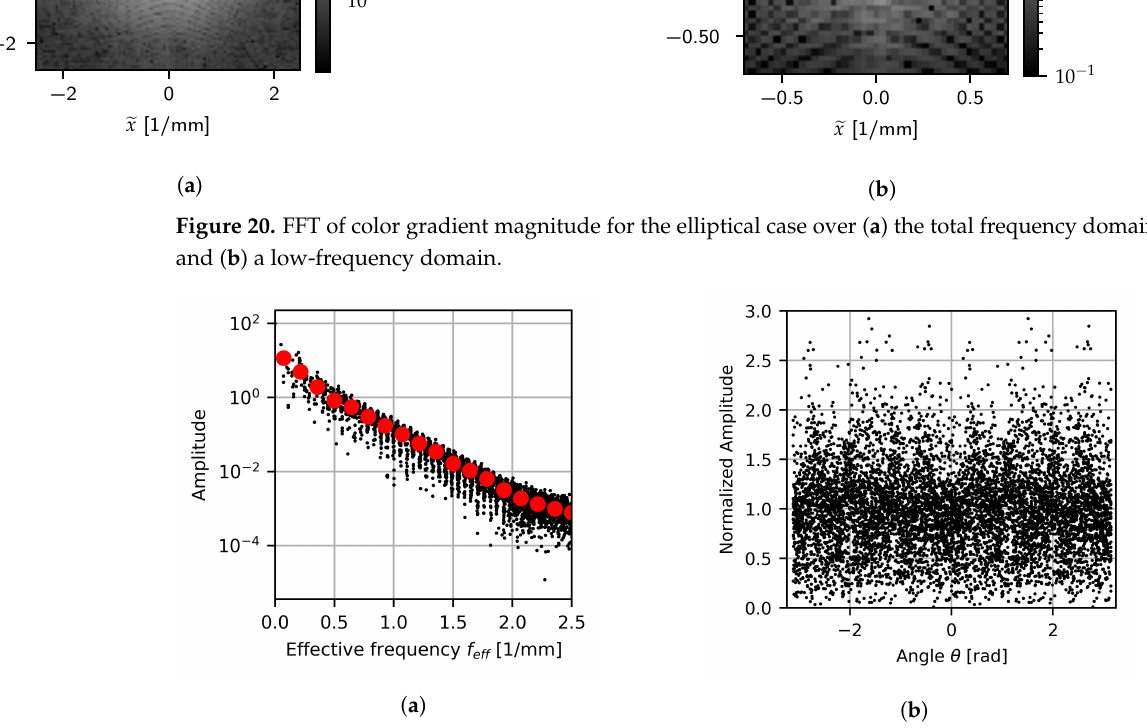
Figure 21. Projected FFT color gradient magnitude as a function of ( a ) effective frequency and ( b ) aspect ratio for the cylindrical outlet